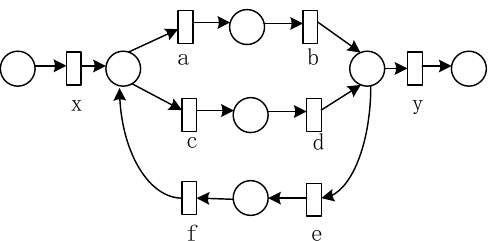
Figure 11. Loop substructure with an exclusive structure.